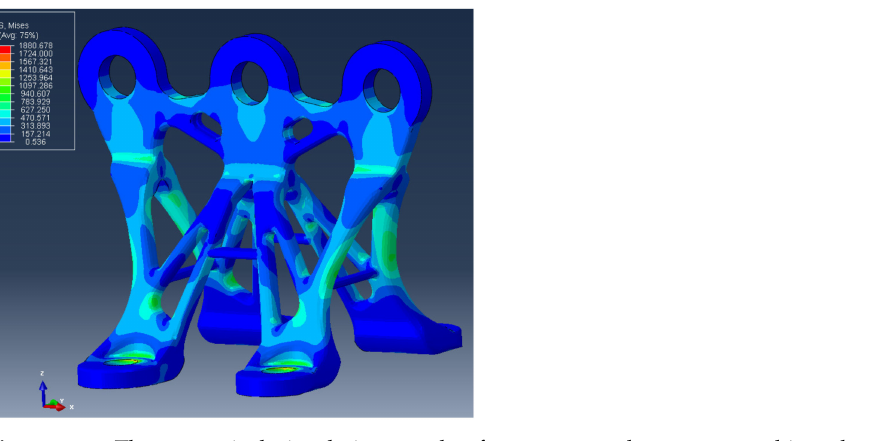
Figure 17. The numerical simulation result of reconstructed geometry subjected to 100 kN vertical